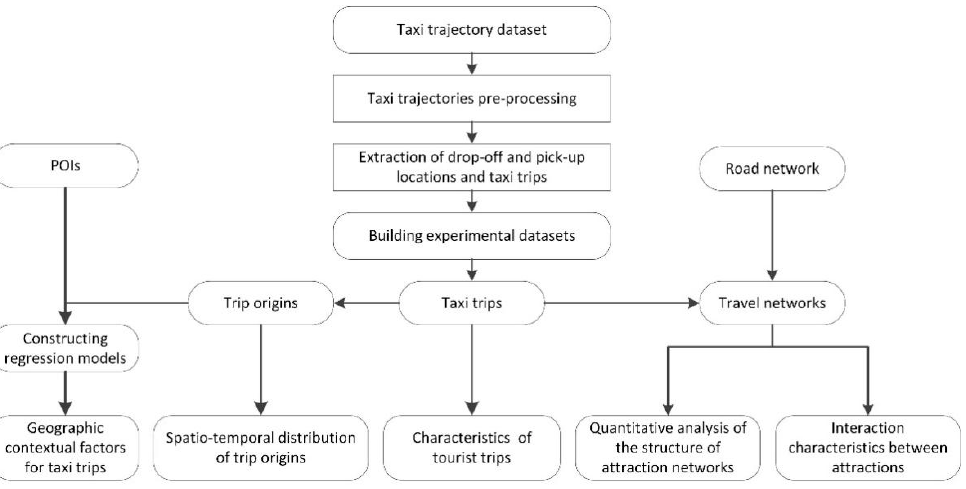
Figure 2. Methodological framework. Step 2: Spatial aggregation of tourist trip origins and spatial dependence on geo- graphic contextual